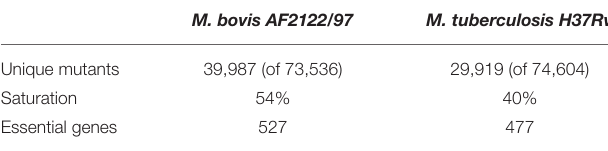
TABLE 3 | Summary statistics of the Tn libraries created in this